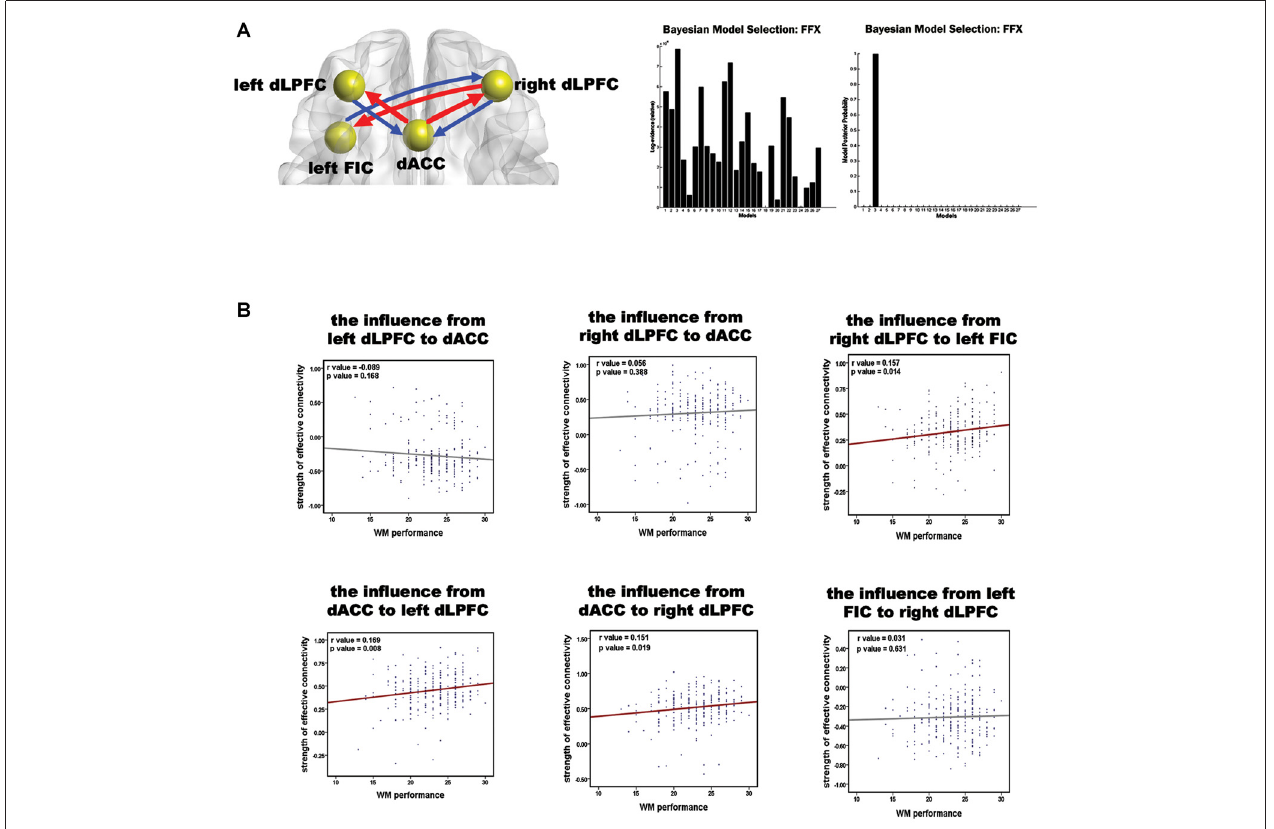
FIGURE 3 | Results of the spDCM analysis and the correlation analysis of the effective connectivity and WM performance . (A) The structure of the optimal model and the group level BMS from 27 alternative models. In the left diagram, the spheres indicate the VOIs used in the spDCM analysis, and the red arrows represent the effective connections correlating with WM performance. The right graphs show the fixed effects BMS in terms of the log-evidence and model probability. (B) Results of the correlation analysis of the effective connections and WM accuracy. Red regression lines indicate that the correlation between the effective connection and WM accuracy was significant ( p < 0.05, corrected); the gray lines indicate that the correlation was not significant.